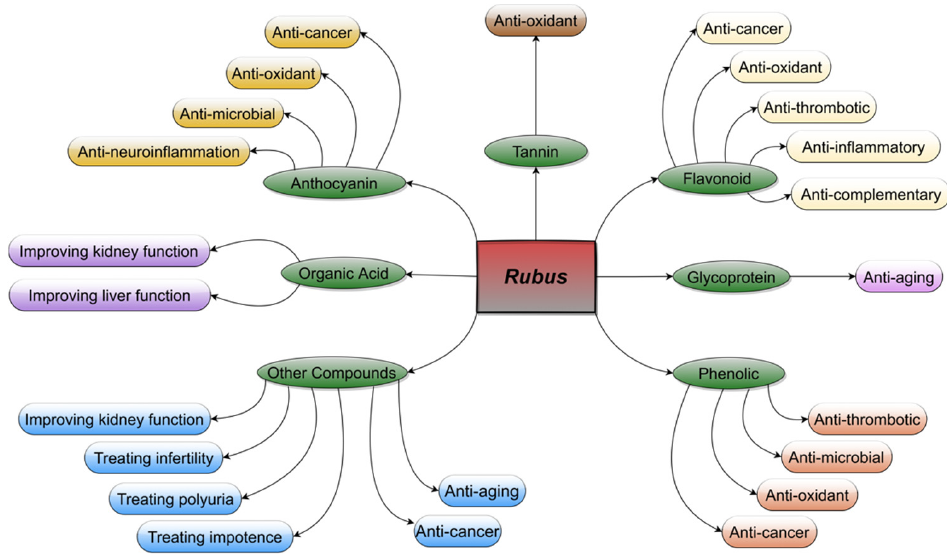
Figure 2. Schematic description of the secondary metabolites of Rubus and their medicinal benefits to humans. The central red rectangle represents the wild Rubus species, the seven green ellipses represent the major secondary metabolites of Rubus , and the outermost ellipses represent the main medicinal functions of secondary metabolites. The various colors show different effects on human health.